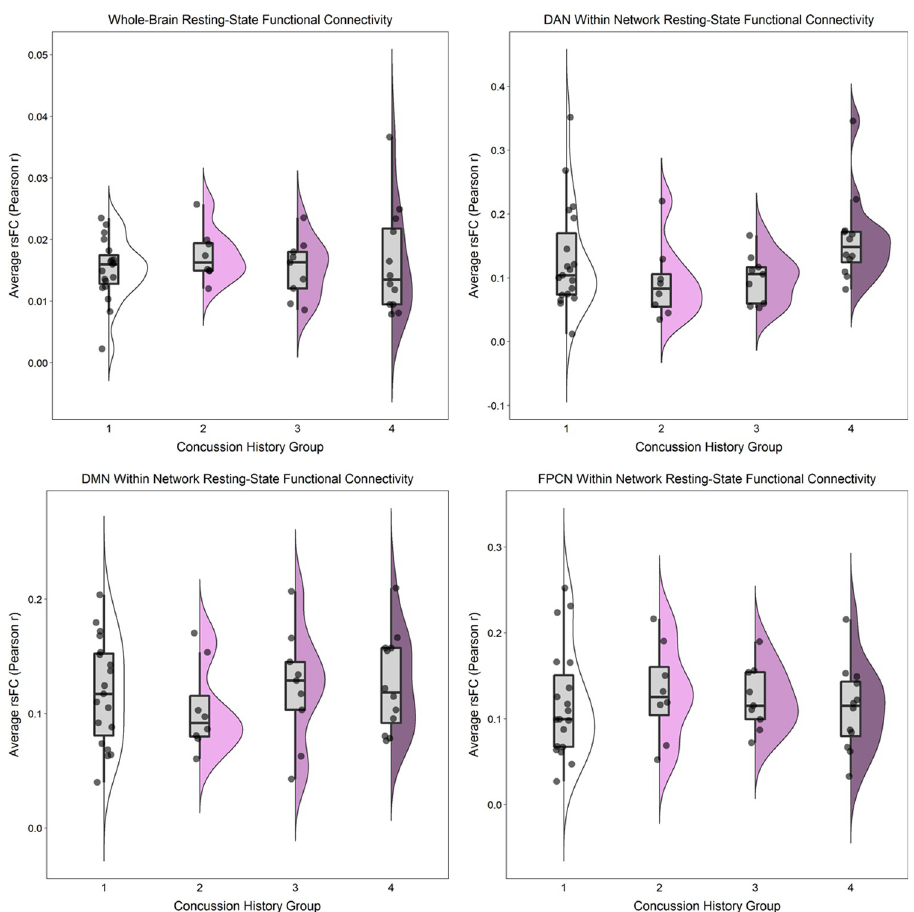
Fig 3. Whole-brain and within-network resting-state functional connectivity (rsFC) in large-scale networks separated by four ordinal concussion history groups. Whole-brain rsFC (top-left) was calculated as the average Pearson r correlation (y-axes) between each of the 300 regions of interest (ROIs) and all other ROIs across the time- series. Within-network rsFC for the Dorsal Attention Network (DAN; top-right), the Default Mode Network (DMN; bottom-left), and the Frontoparietal Control Network (FPCN; bottom-right) was calculated as the average Pearson r correlation between each of the individual ROIs from the given network and all other ROIs within that same network across the time-series. Individual points represent participant-level outcomes for each measure within each of the concussion history groups (1 = 0 or 1 concussion [ n = 19]; 2 = 2 to 4 concussions [ n = 8]; 3 = 5 to 7 concussions [ n = 9]; and 4 = 8 or more concussions [ n = 12]). Boxplots represent the median and interquartile range, and the whiskers extend to 1.5 times the interquartile range. The violin plot is a depiction of the density of individual rsFC values for each